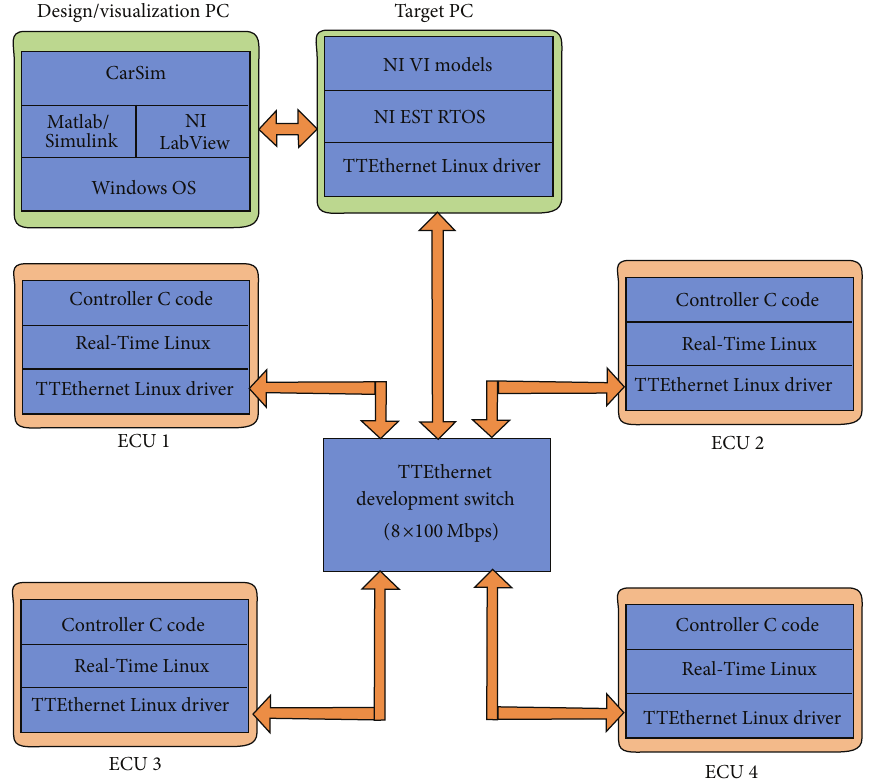
Figure 3: System Architecture for the Experimental